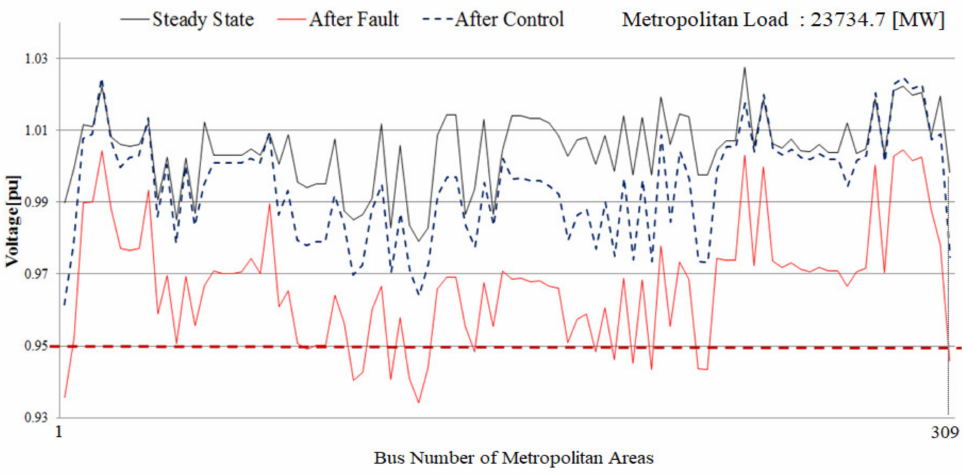
Figure 5. Three voltage profiles: pre-fault steady state, after fault state, and after fault with voltage control state.